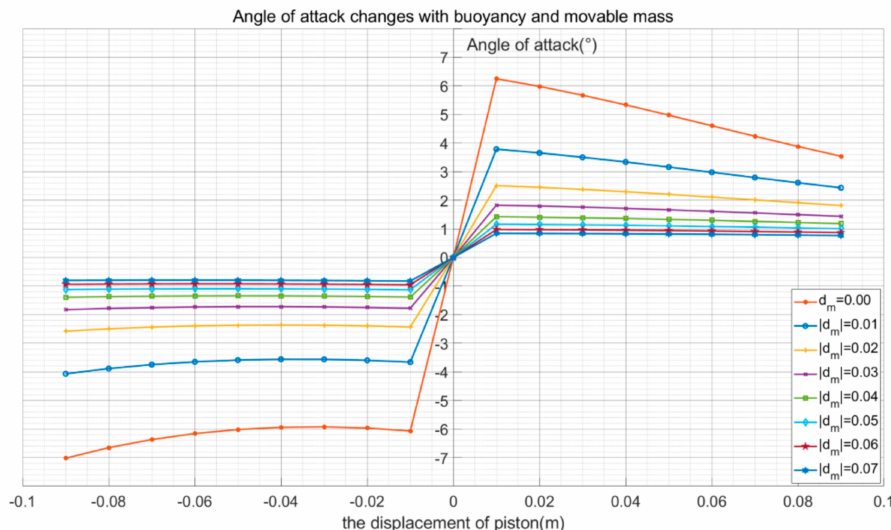
Figure 11. Change in angle of attack with buoyancy and movable mass.